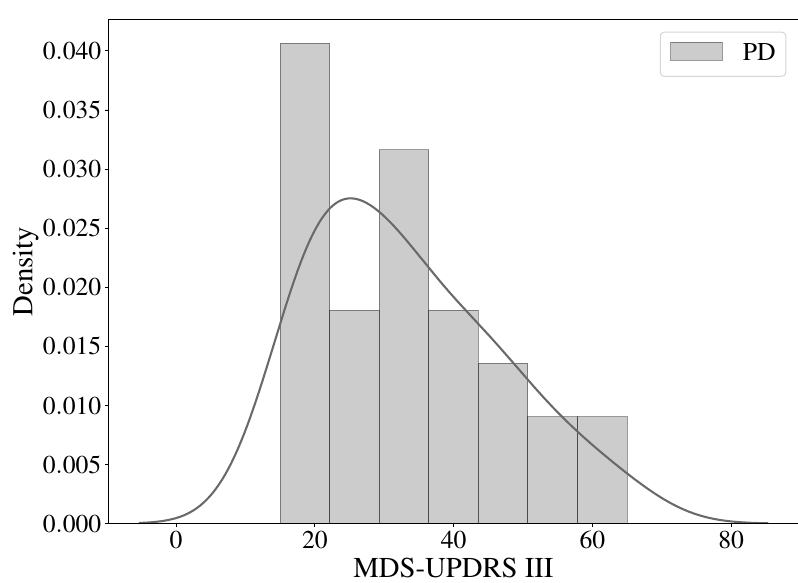
Figure 5. Label count for the MDS-UPDRS-III